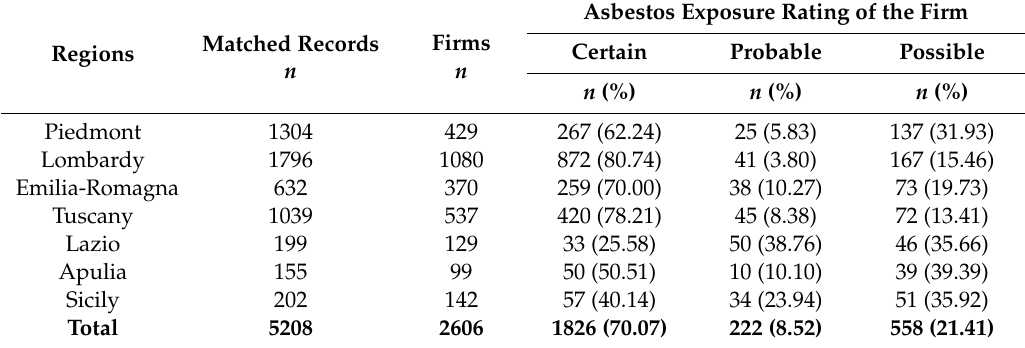
Table 4. The number of firms listed for possible asbestos exposure after the linkage, and distribution of occupational exposure, by region. The total number is smaller than the sum of the number of firms in each region because the firm’s names observed in two or more regions were counted only once.